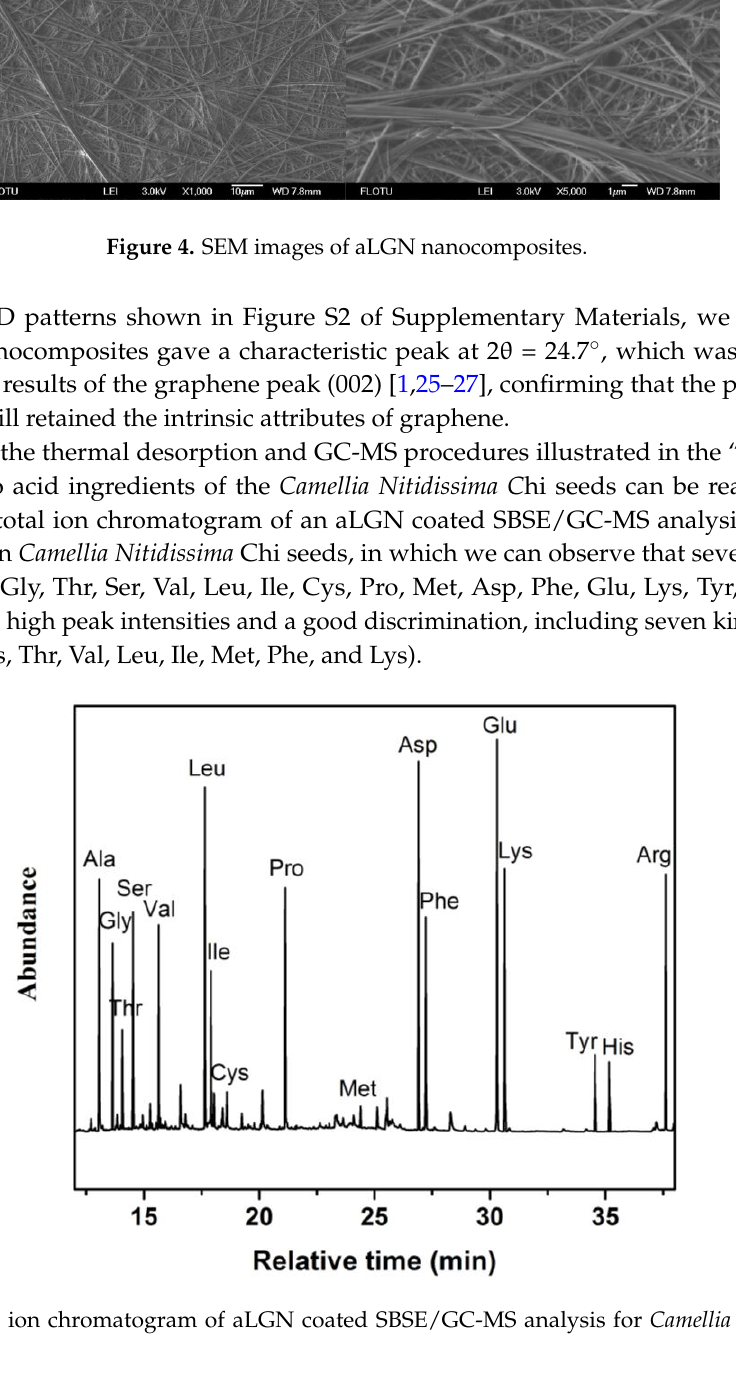
Figure 5. Total ion chromatogram of aLGN coated SBSE/GC-MS analysis for Camellia Nitidissima Chi seeds.